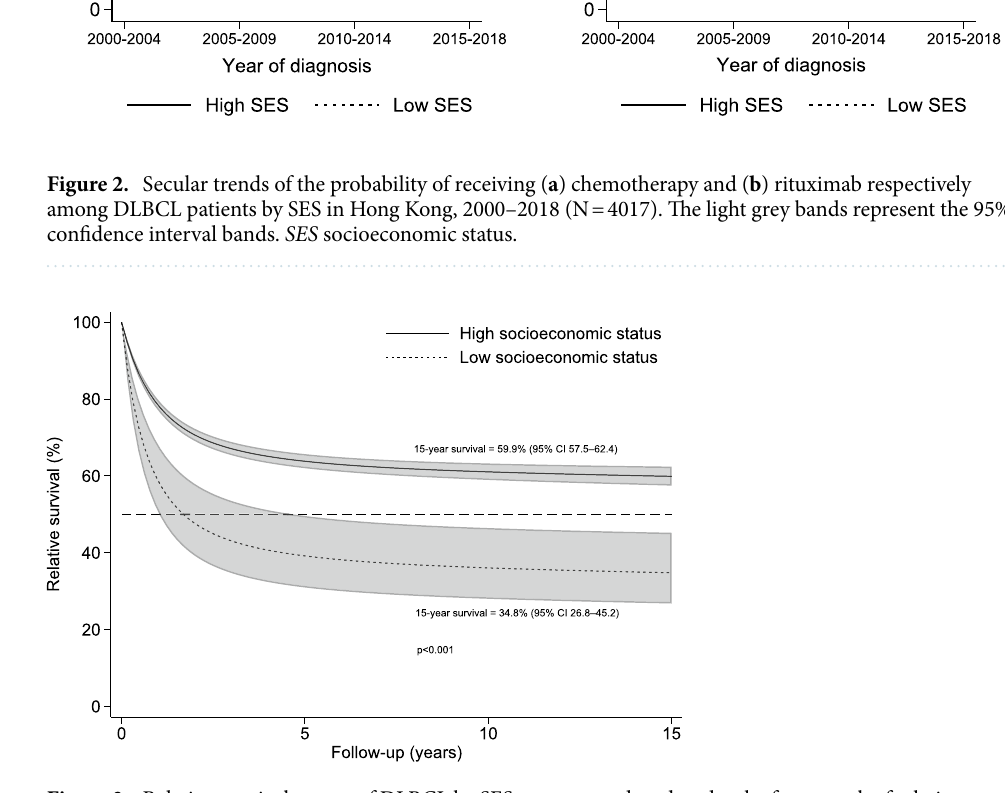
Figure 3. Relative s urvival curves of DLBCL by SES groups, produced under the framework of relative survival using Hong Kong life tables, Hong Kong, 2000–2018 ( N = 4017). The light grey bands represent the 95% confidence interval bands. CI confidence interval, DLBCL diffuse large B-cell lymphoma, SES socioeconomic